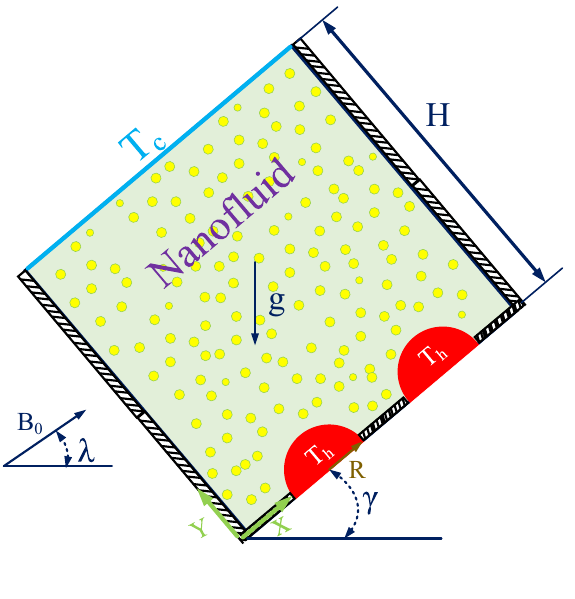
Figure 1. The geometry of the